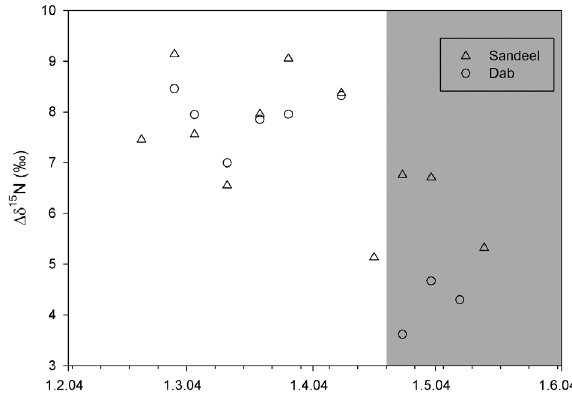
for the stable isotope analysis are shown, individual data are shown for larger larvae. The dataset is divided into pre-phytoplankton bloom (before zooplankton breakdown, n=183) and phytoplankton bloom (after zooplankton breakdown, n=18).